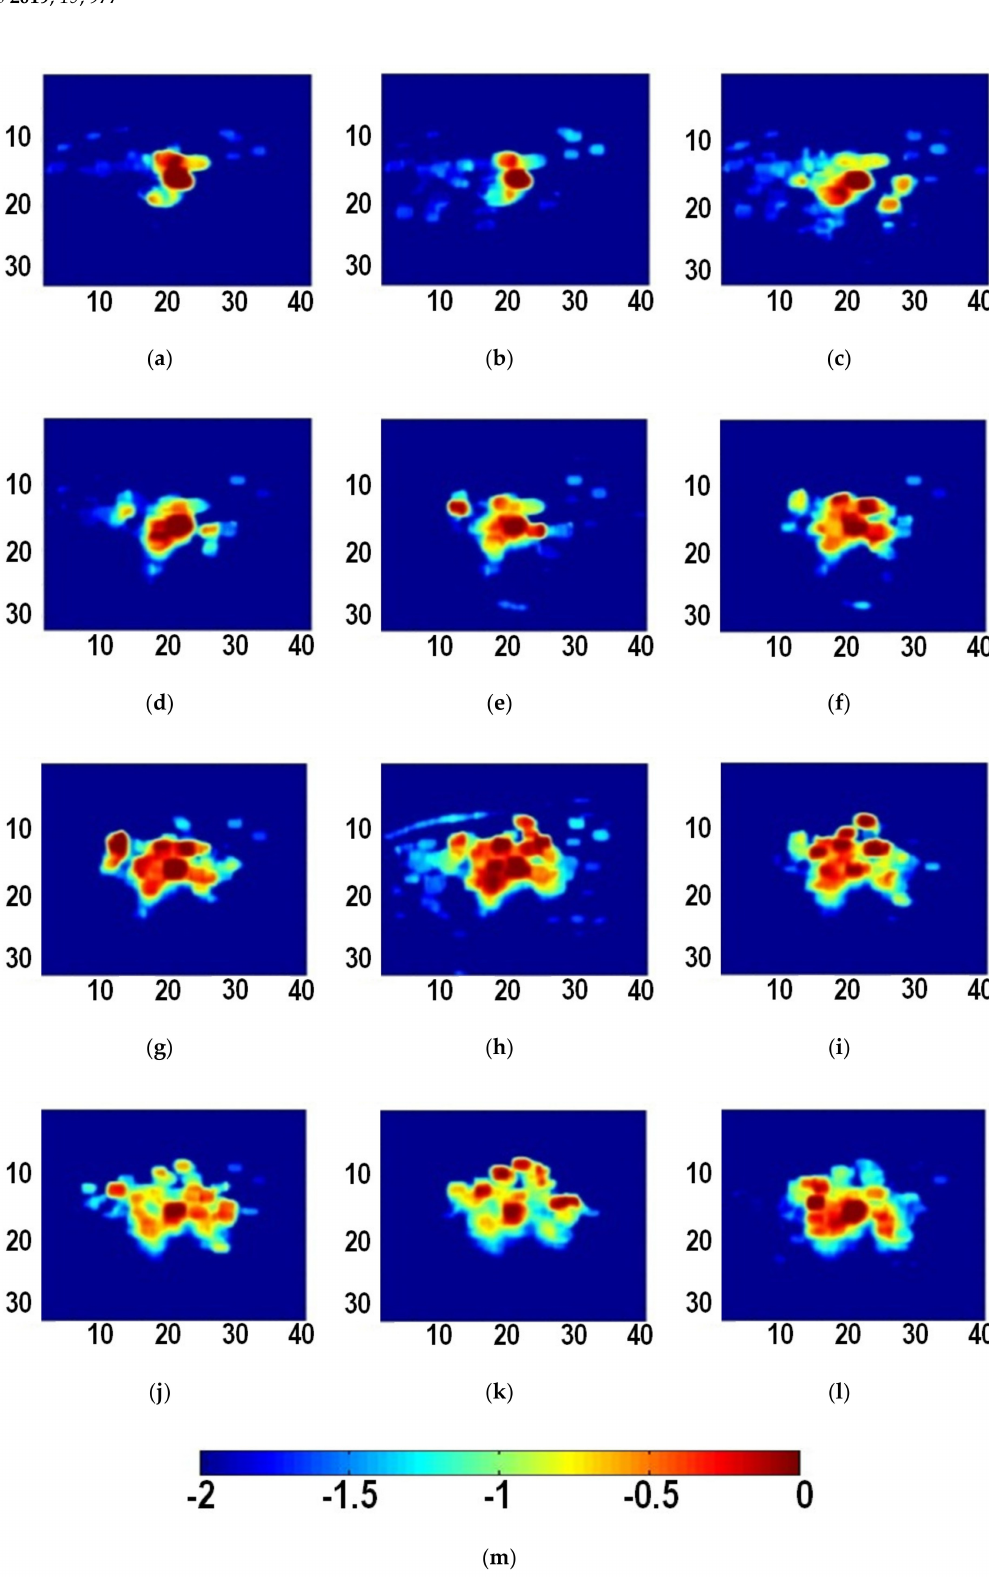
Figure 3. Instantaneous ultrasound echo decorrelation images at different time during ablation. ( a ) 5 s; ( b ) 10 s; ( c ) 15 s; ( d ) 20 s; ( e ) 25 s; ( f ) 30 s; ( g ) 35 s; ( h ) 40 s; ( i ) 45 s; ( j ) 50 s; ( k ) 55 s; ( l ) 60 s. ( m ) is the color bar for ( a – l ). The units of ( a – l ) are mm. The unit of ( m ) is unitless. The maximum value of each pixel in the instantaneous echo decorrelation images was taken to form a cumulative echo decorrelation image. According to the analysis in Section 3.1, and